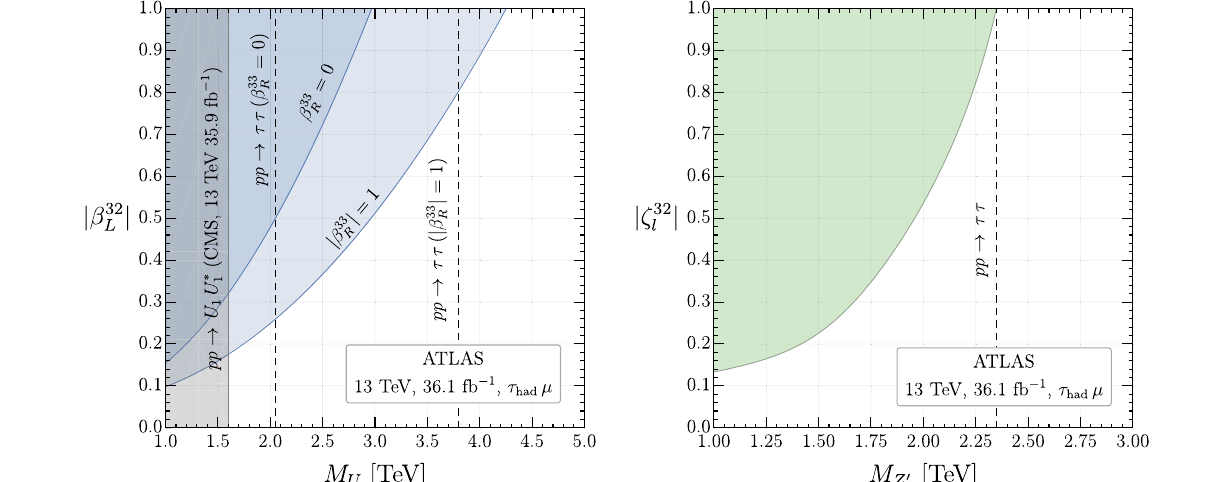
Right: Z (cid:2) limits in the (ζ 32 the Z (cid:2) and fixing g Z (cid:2) = 3. For comparison, the bounds from U 1 pair- . R production and from pp → ττ are also shown